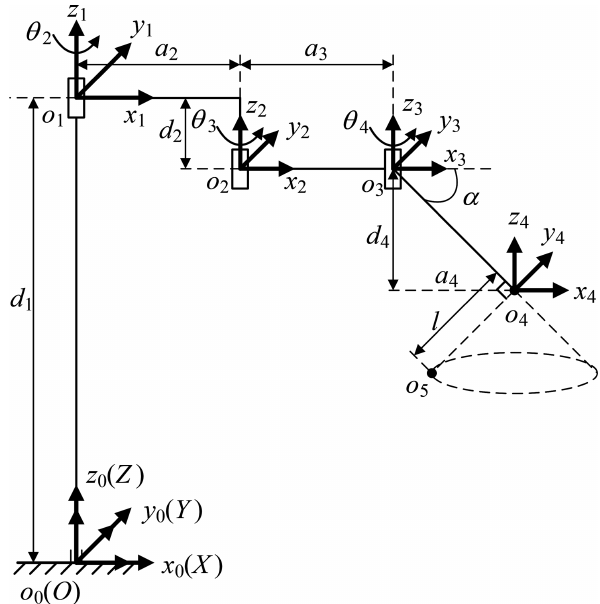
Figure 7. The mechanism diagram of the telecentric fixed-point positioning mechanism.